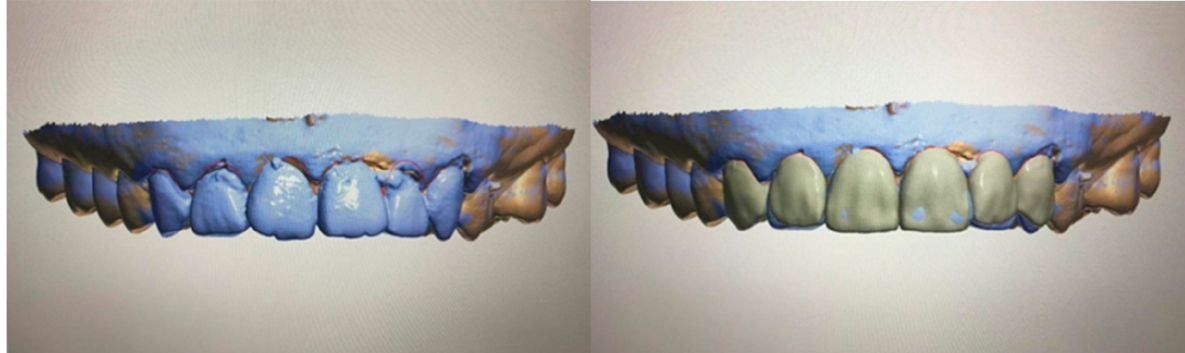
Figure 1. Virtual design in prosthodontics depicting tooth designing done digitally to amend slight rotation and tilting of the front teeth. The left picture shows a misaligned front dentition and the right picture shows the dentition after digital modifications. The final standard triangle language (STL) file is able to be three-dimensionally printed using specific resin via a 3D printer and can be used as a communication tool with the dental technician.